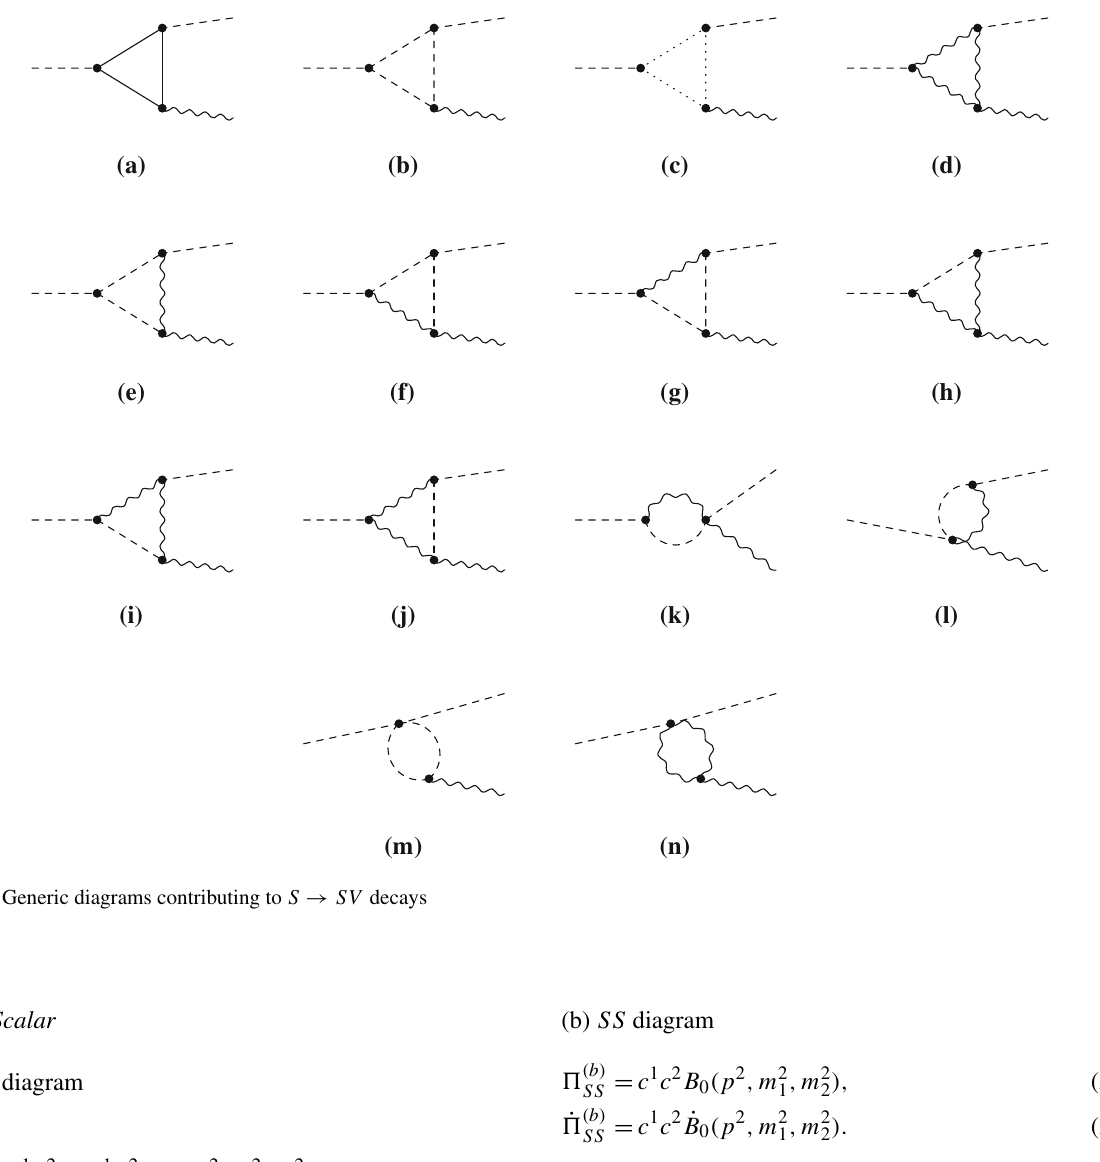
Fig. 19 Generic diagrams contributing to S → SV